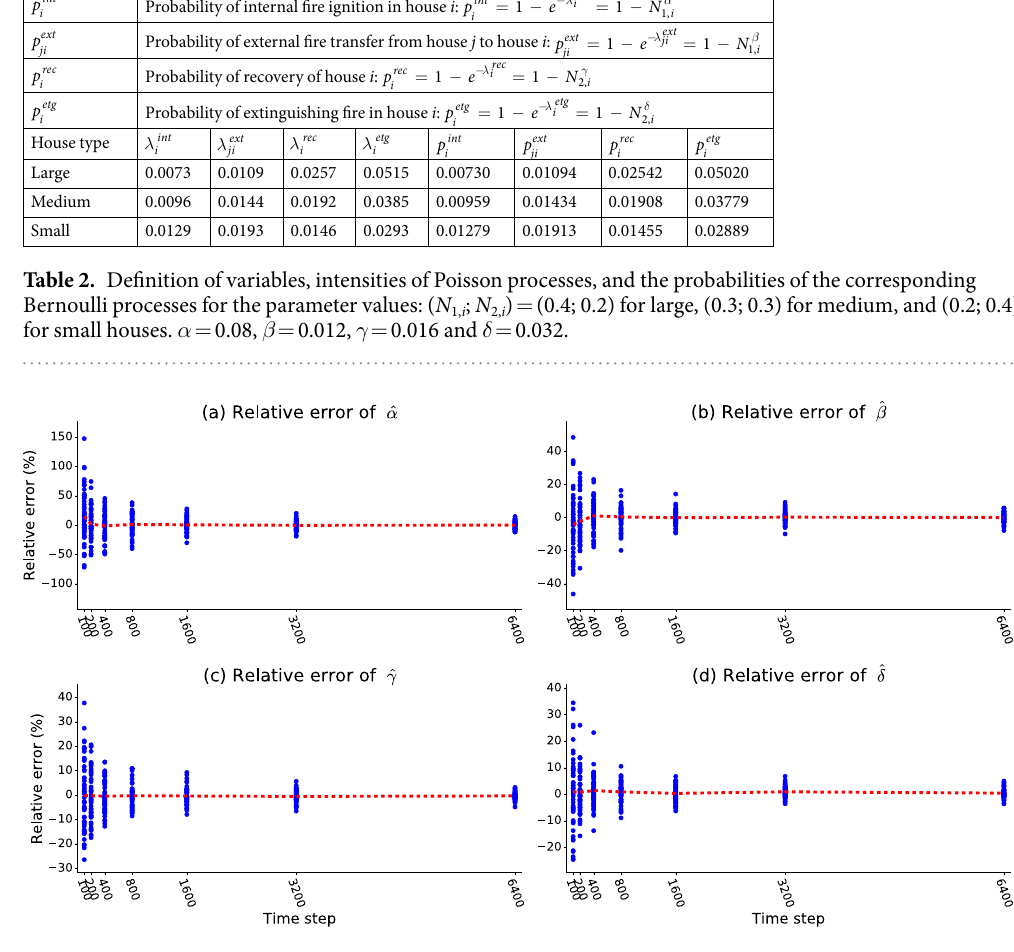
then slowly as historical data size increases. The double-logarithmic plot in Fig. 3(b) has slope close to − 0.5, which shows that the standard deviation decreases in a power-law fashion as the training data size increases. For real-world case processes, it is impossible to get multiple historical datasets for parameter recovery, yet recovery error based on single dataset may be different from the one based on the average of such recovered values on multiple datasets. Hence, we study how sensitive our methodology is to imperfect input datasets. In